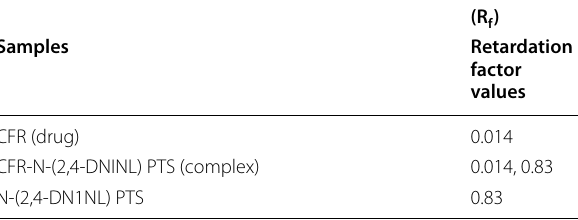
Table 1 Result of TLC analyses: mobile phase system used: